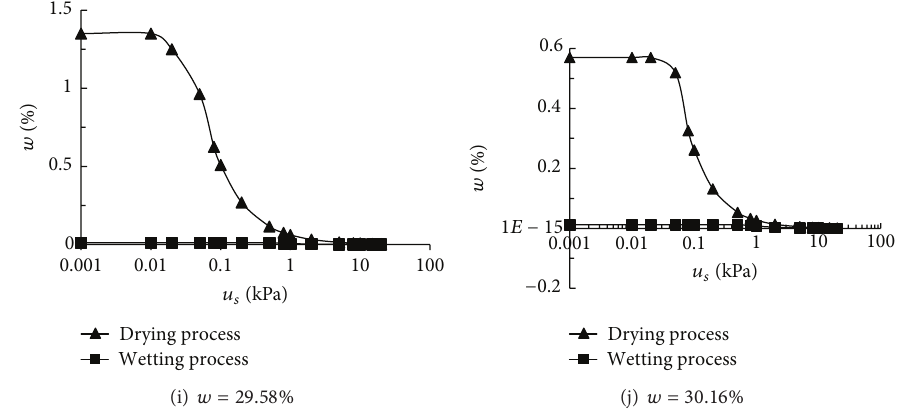
Figure 9: The SWCC for the crack network at various water